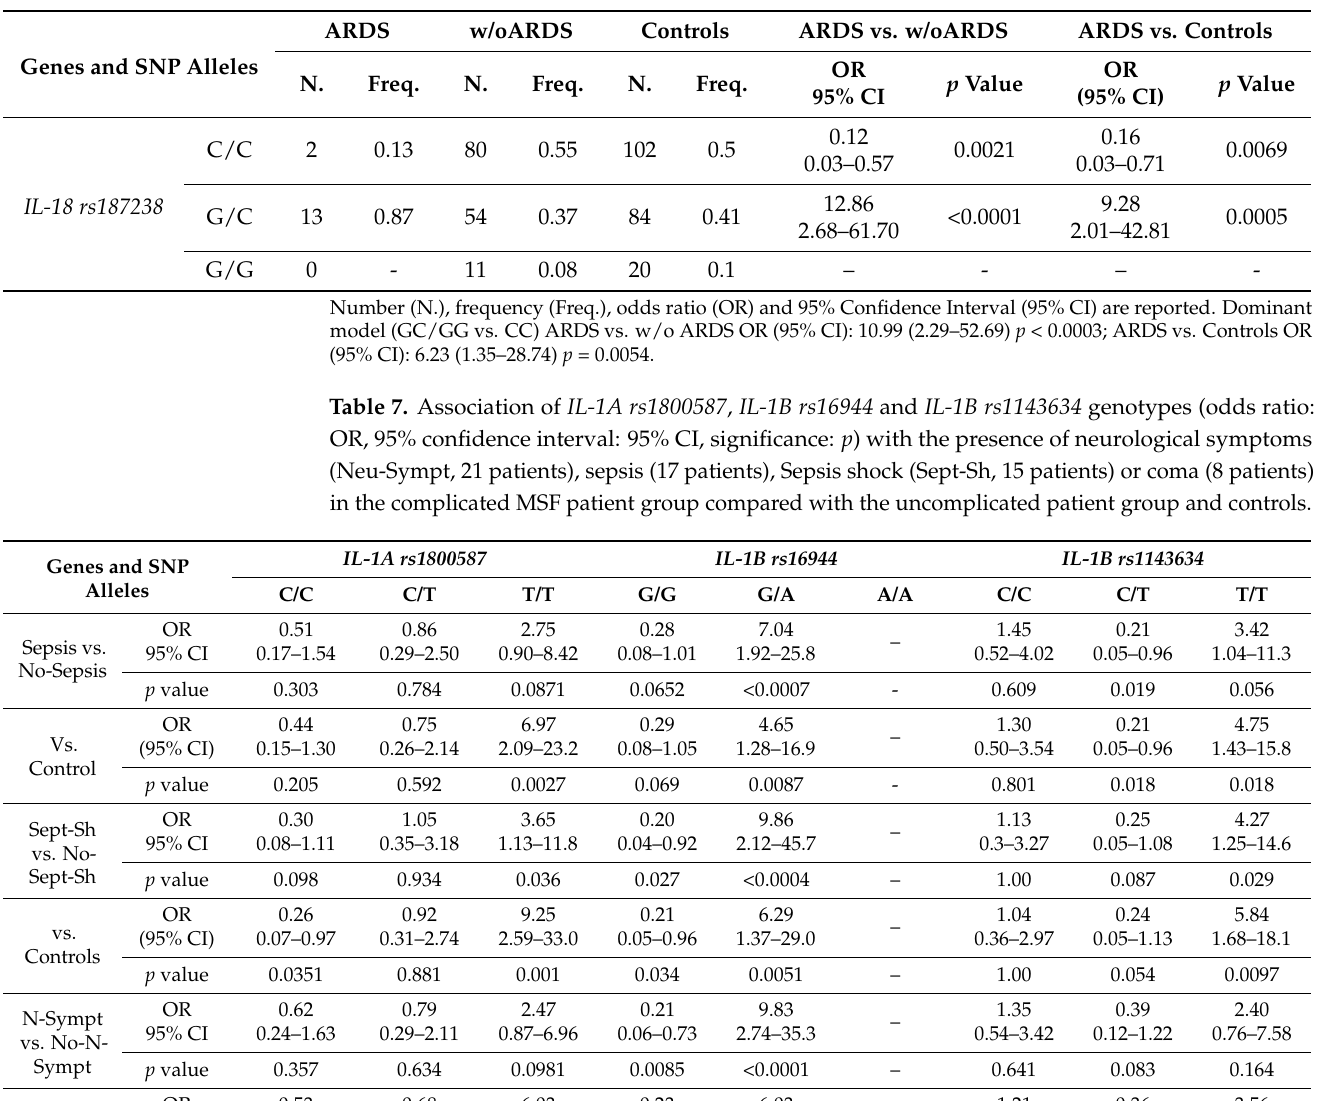
all the five SNP typed are reported in supplementary Table S1 (Analysis of SNPs association with Acute Respiratory Distress Syndrome), Table S2 (Analysis of SNPs association with Neurologic symptoms), Table S3 (Analysis of SNPs association with with Sepsis), Table S4 (Analysis of SNPs association with Septic shock) and Table S5 (Analysis of SNPs association with Coma). Significant results were obtained for IL-18 rs187238 SNP (Table 6) and for SNPs located in the IL-1 gene cluster (Table 7). The data reported in Table 6 indicated that